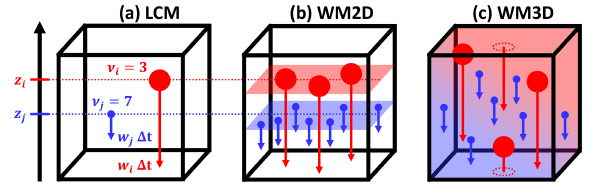
Figure 2. Grid box with a SIP pair in the LCM world (a) and its respective interpretation in the 2D well-mixed (WM2D, b ) and 3D well-mixed (WM3D, c ) approach of the AON collisional growth algorithm.